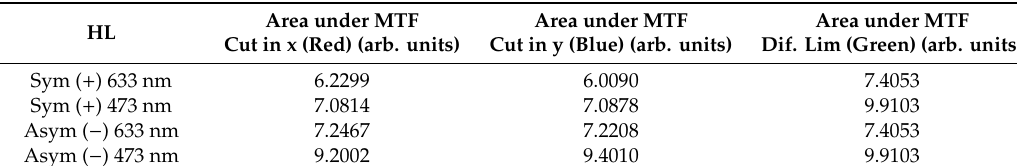
Table 5. Image quality based on impulse response and Fourier domain.